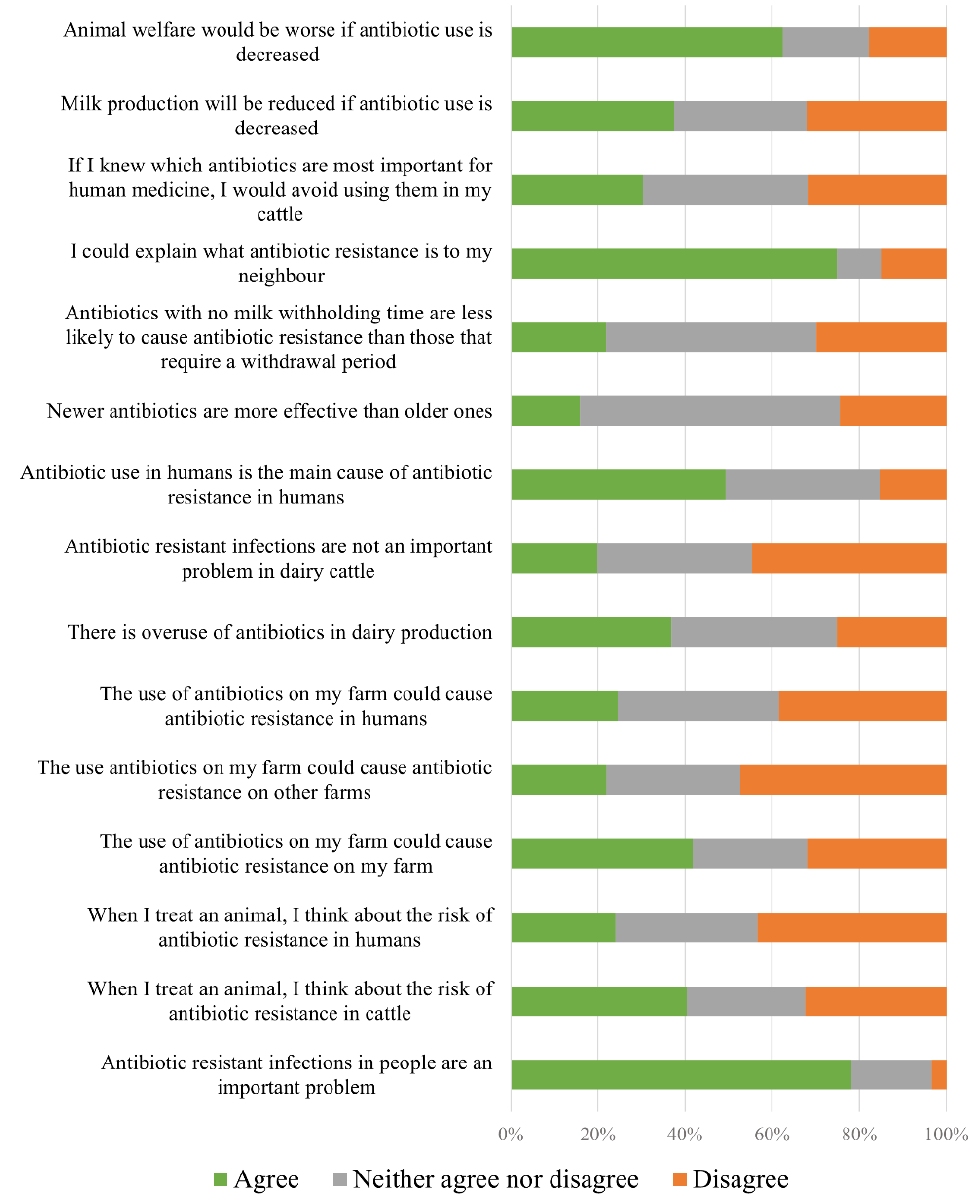
Figure 2. Summary of the 151 dairy farmer respondents’ level of agreement to 15 statements regarding antimicrobial resistance and antimicrobial use reduction.